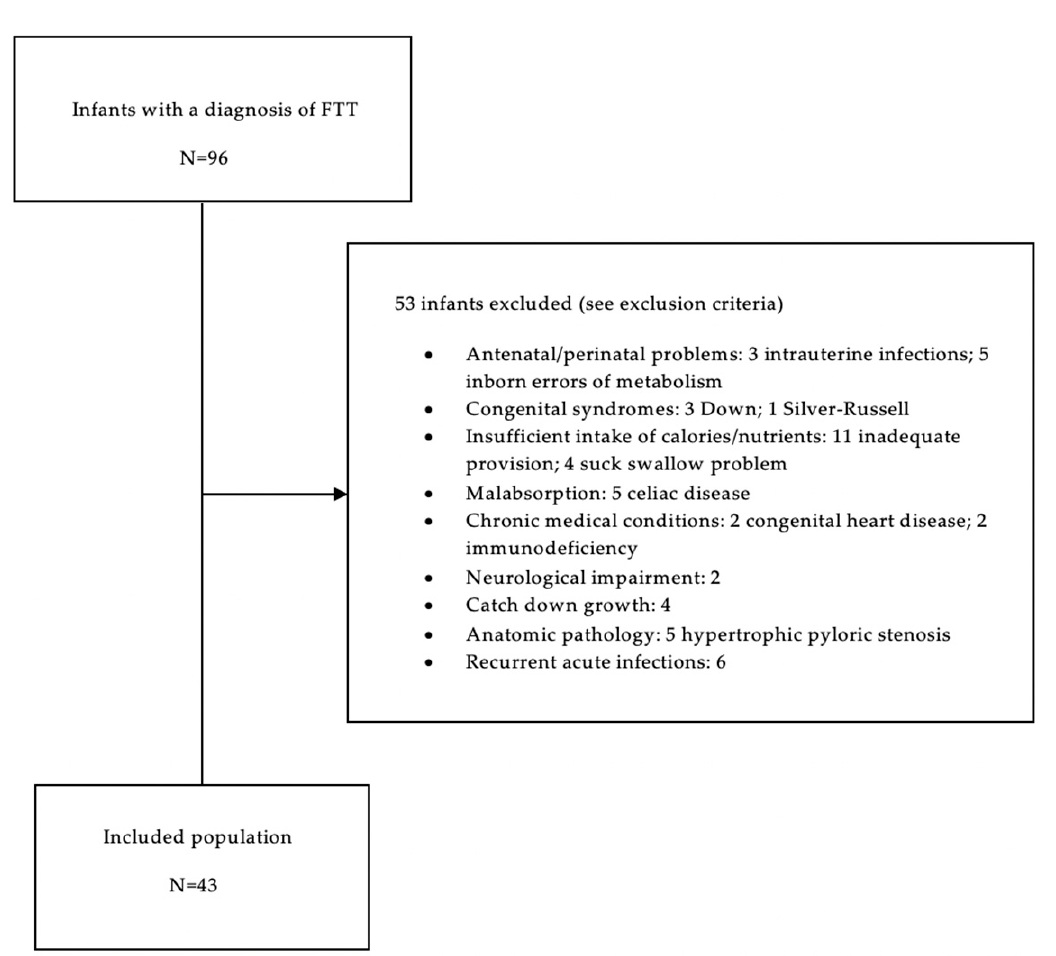
Figure 1. Study flow chart showing the screened cohort of 96 infants, and the included group of 43. Clinical features, diagnosis, and allergic evaluation of the 43 infants are shown in Table 1.